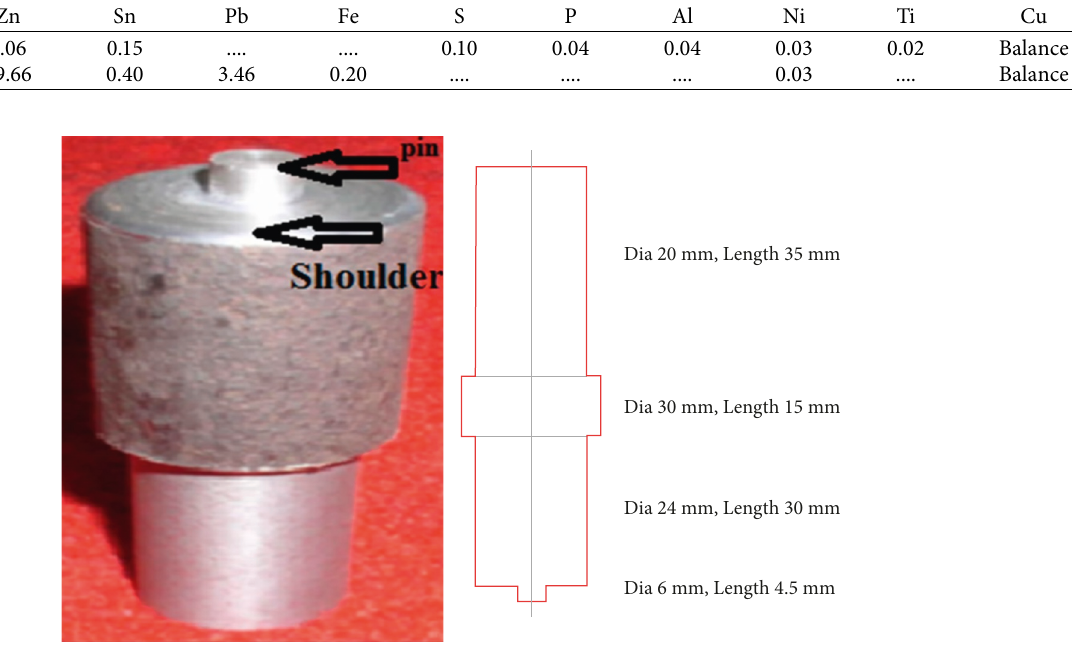
Figure 1: FSW H13 tool